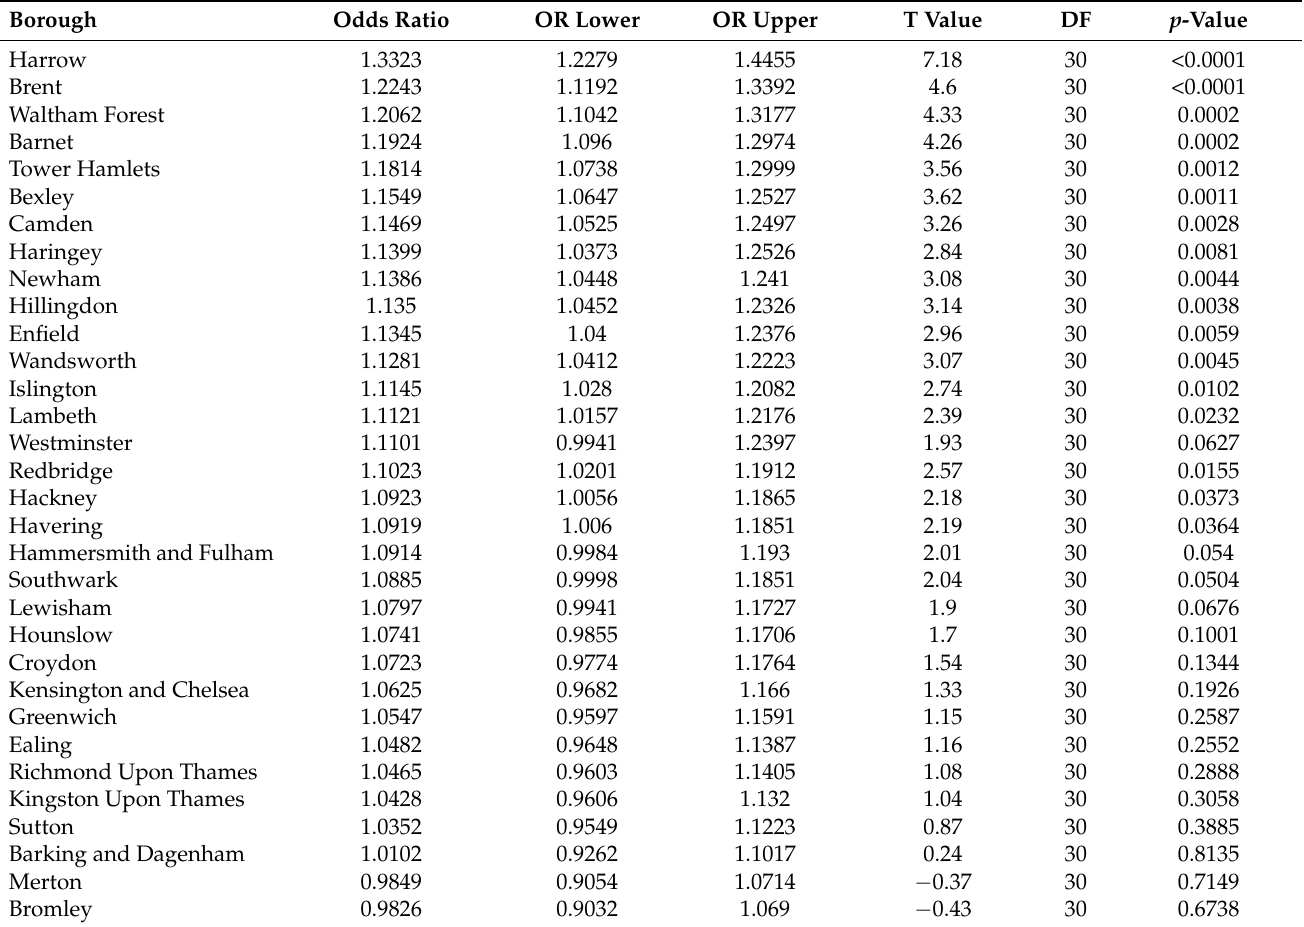
Table 1. Cluster-specific time trend (Odds Ratio sorted in descending order).